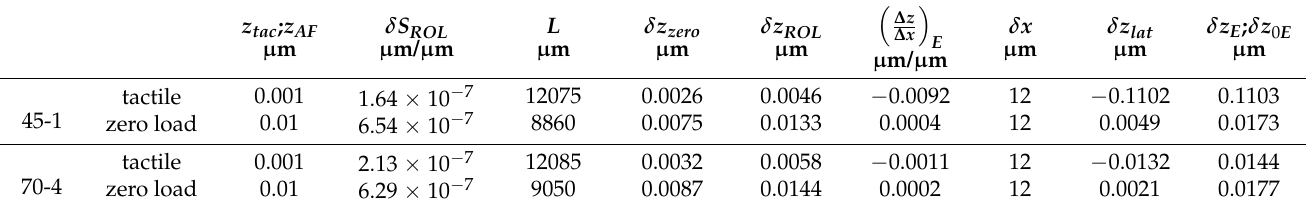
Table 10. The budgets of the uncertainty of z E and z E 0 of the cantilevers 45-1 and